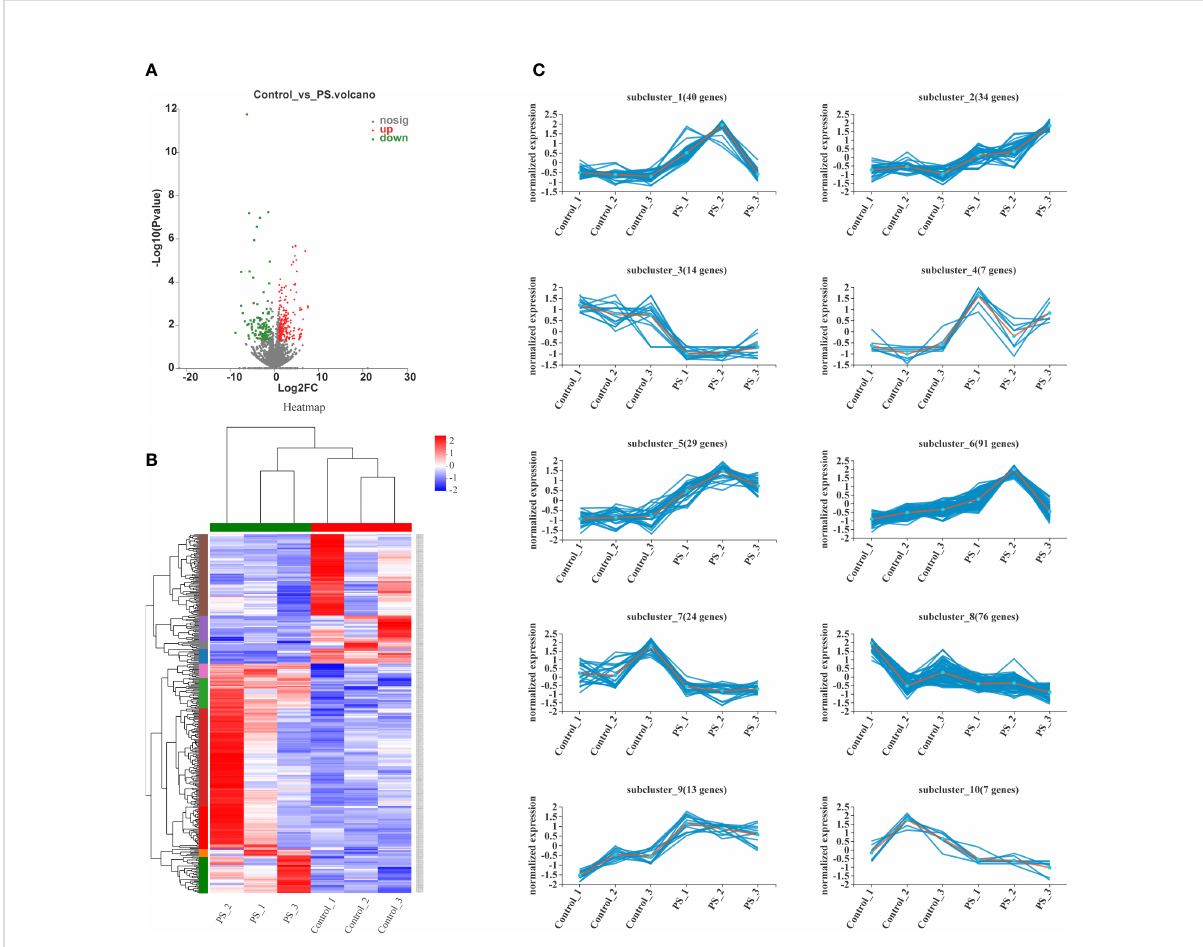
FIGURE 3 Analysis of differentially expressed genes (DEGs). (A) Volcano plots of the DEGs in control vs . polysaccharides. The red, blue, and gray dots indicate signi fi cantly upregulated, signi fi cantly downregulated, and non-signi fi cantly expressed genes, respectively. (B) Heat map of DEG expression pro fi les in all samples. The colors ranging from blue to red indicate the genes expressed from low to high levels. (C) Ten different expression patterns analyzed of 335